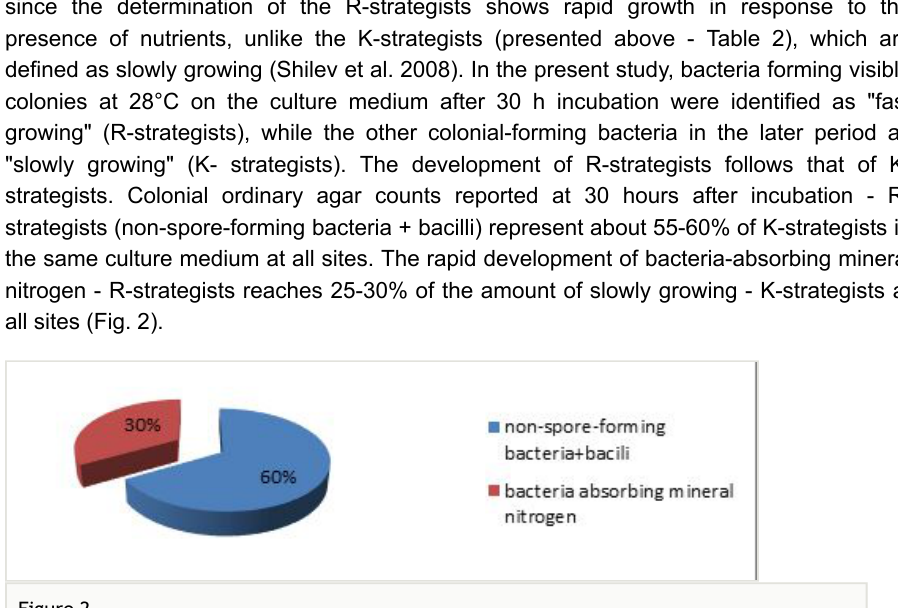
Figure 2. Participation of R-strategists and K-strategists in %.